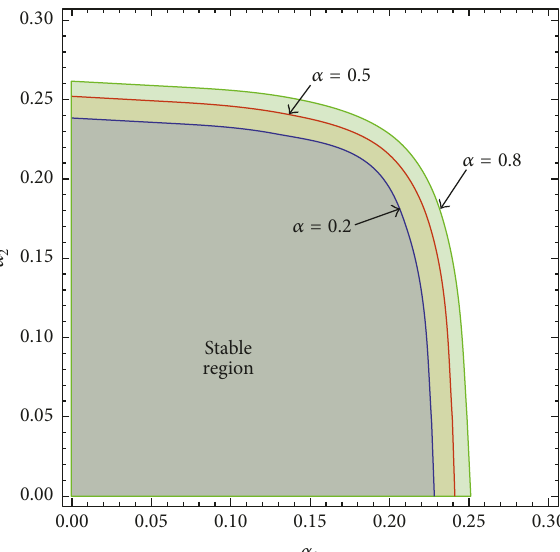
Figure 10: The stable region of adjustment speeds when 𝜃 = 0.6 , 𝛼 = 0 , and 𝑤 = 𝑤 . 𝑖